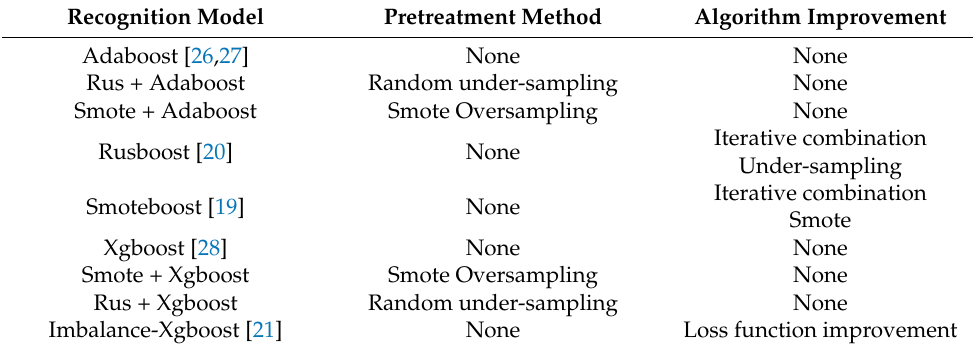
Table 2. List of recognition